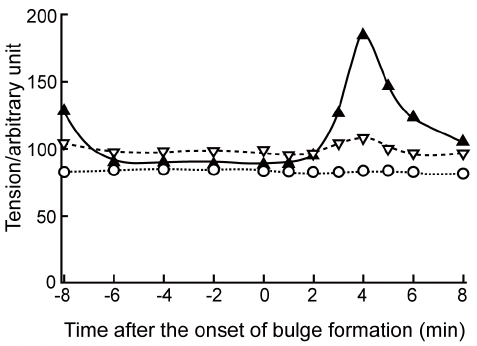
Figure 4. Global changes in the tension at the surface of the oocytes. The tension at the surface is calculated by the rough estimation based on the images shown in Fig.3. Abscissa: time after the onset of bulge formation. Ordinate: Tension, ( T1 + T2 )/2, averaged over 20 degrees at the animal pole (solid line with filled triangle), that at the vegetal pole (broken line with open triangle), thdat at the equator (dotted line with open circle).